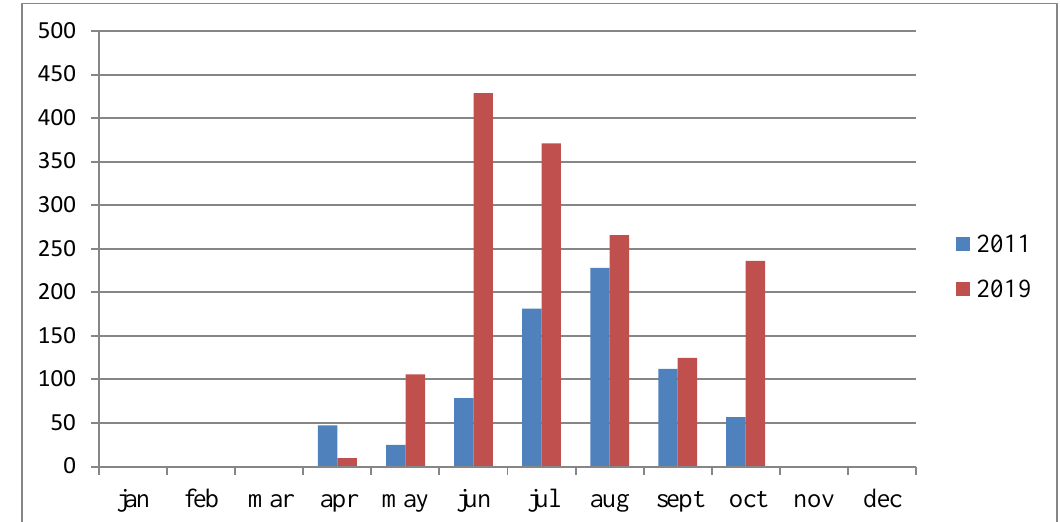
Figure 7: Comparison between the driest and wettest year.